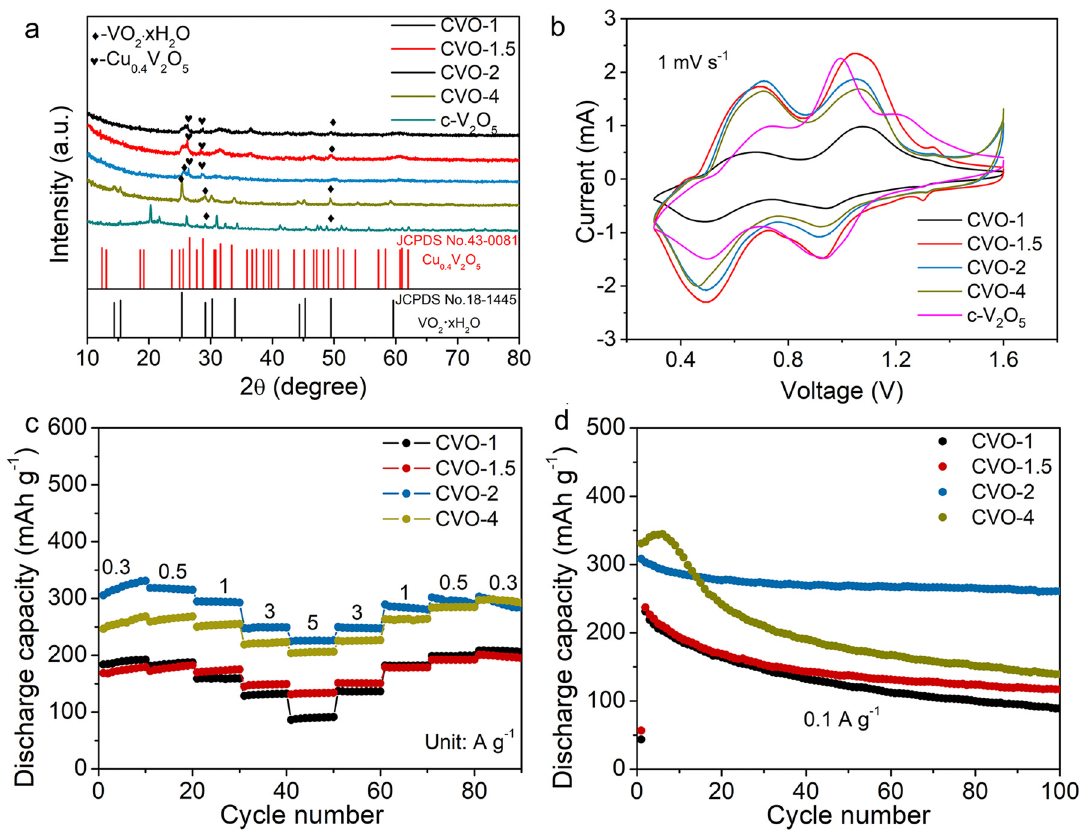
Figure 2: ( a ) The XRD patterns and ( b ) CV curves of CVO - 1, CVO - 1.5, CVO - 2, CVO - 4, and c - V 2 O 5 . ( c ) Rate performance and ( d ) cycle performance of CVO - 1, CVO - 1.5, CVO - 2, and CVO -